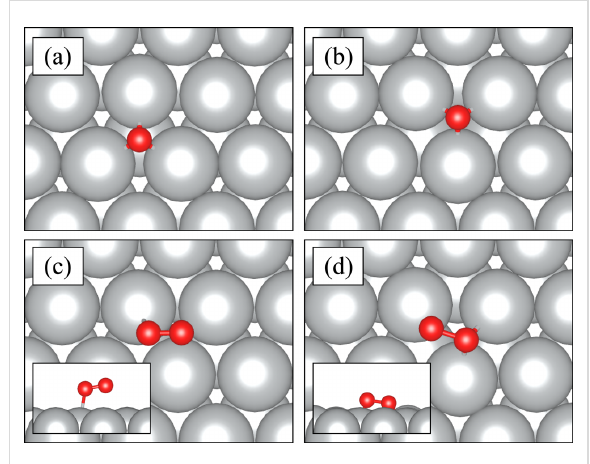
Figure 2: Top view of Ag(111) geometric structures after capturing an oxygen atom and an O 2 molecule. (a) hcp hollow site and (b) fcc hollow site for oxygen, (c) magnetic and (d) nonmagnetic O 2 molecule adsorption on Ag(111). The insets in panel (c) and panel (d) show the bonding characteristics of O 2